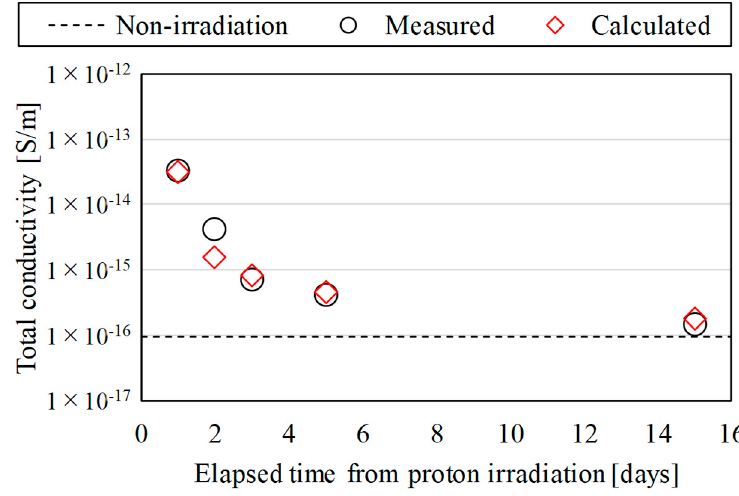
Figure 8. Calculated results of the total conductivity of the proton irradiated samples at 180 min after the start of the measurements. The change over time of conductivity under the irradiation energy condition of 2.0 MeV.